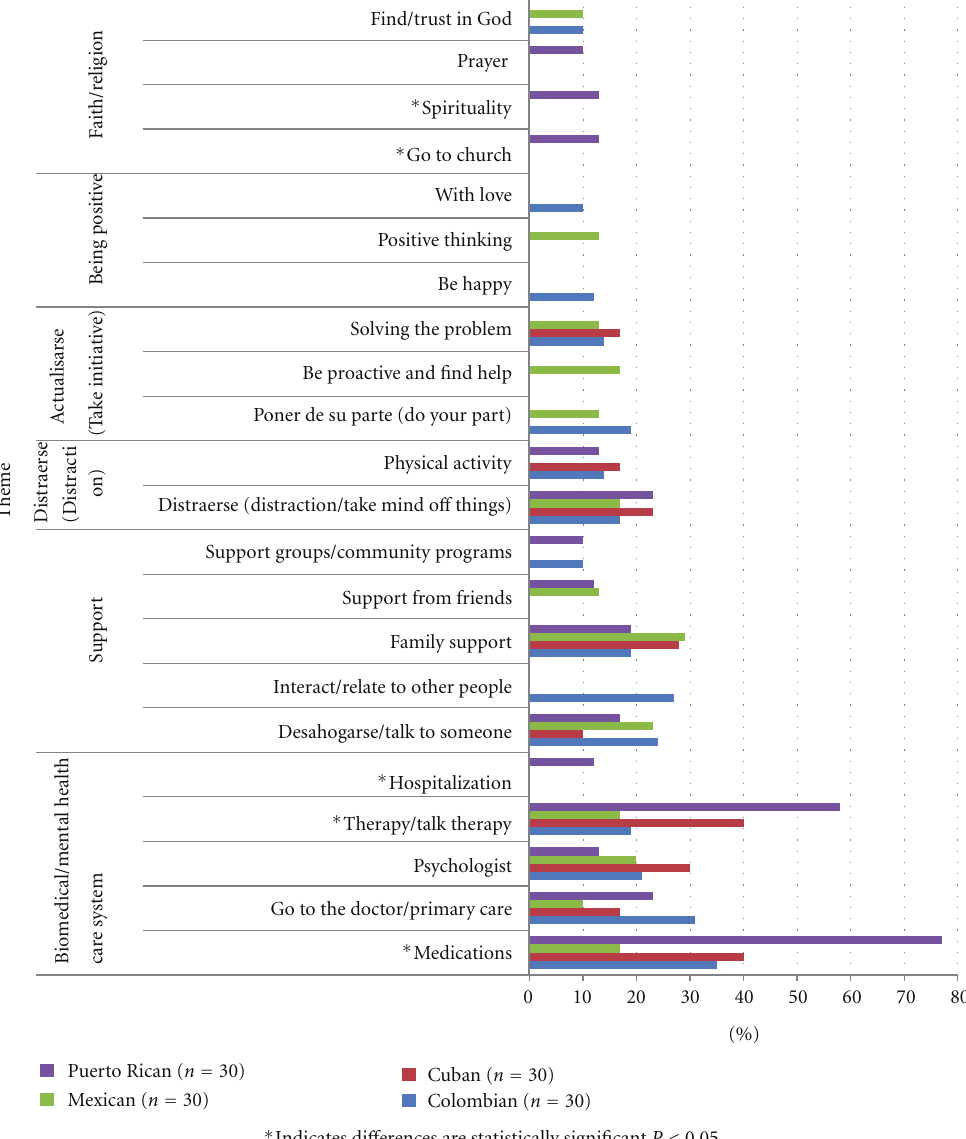
Figure 3: Most frequently listed treatments for